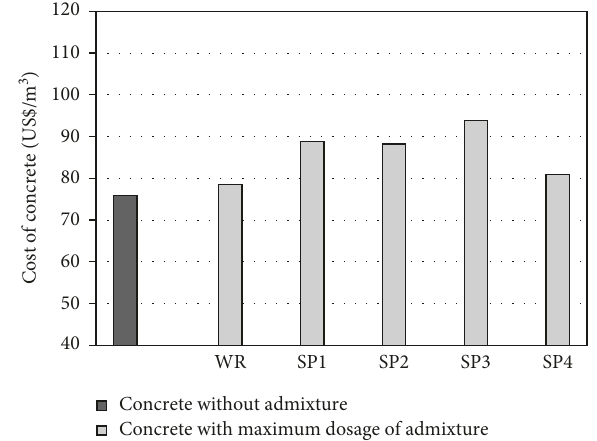
Figure 7: Costs of 1 m 3 of concretes (W/C (cid:31) 0.40, s/a (cid:31) 0.40, and C (cid:31) 340 kg/m 3 ) prepared with maximum recommended dosages of different types of chemical